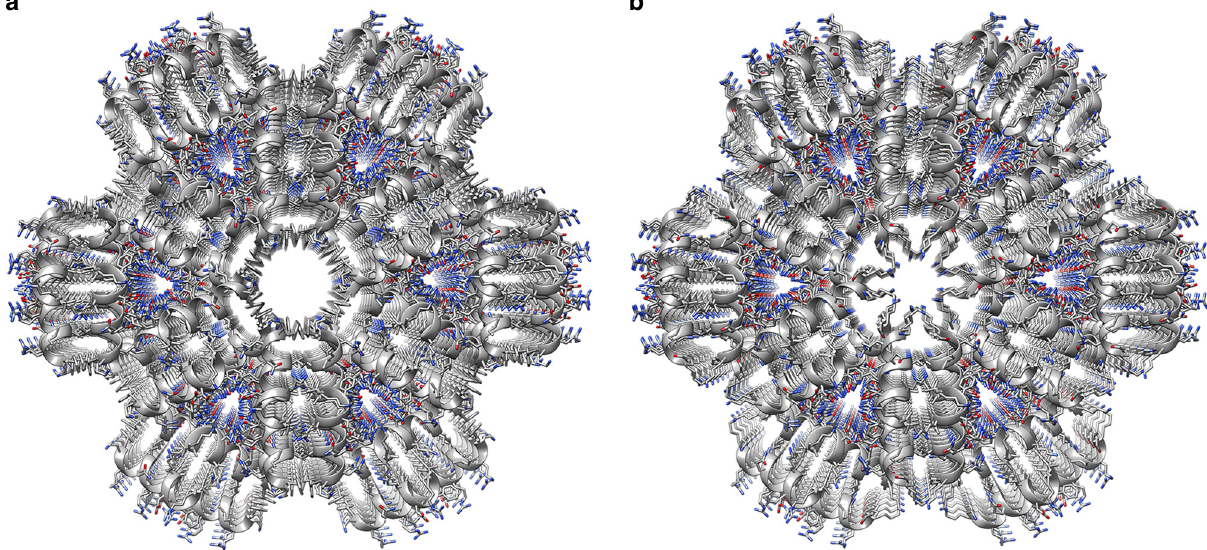
Fig. 7 Human and gorilla LL-37 17-29 share fi brillary architecture but differ in central pore properties. Comparison of human ( a ) and gorilla ( b ) LL-37 17-29 crystal structures, shown in grey ribbons with side chain shown as sticks colored by atom type (oxygen in red and nitrogen in blue). The view is down the fi bril axis, showing the hexametric arrangement and the central pore. The overall structure of the two is highly similar (RMSD of 0.15 Å for the asymmetric unit, comprising two helices and a similar space group and unit cell dimensions (Table 1)). The N-termini of the helices, with Phe17 in hLL-37 17-29 or Ser17 in gLL-37 17-29 , and Lys18, line the central pore. The pore of gLL-37 17-29 is more occluded, due to the orientation of the lysine residues extending into the pore. In the hLL-37 17-29 structure, the lysine residues are almost perpendicular to the cross-section of the curves. MIC values were de fi ned as the minimal concentration of the peptide which yielded less than 20% of the AUC of the control (bacteria with no added peptides). All experiments were performed in triplicates and were averaged. The entire experiment was repeated at least three times on different days, and the mean was calculated from the averaged triplicates of all biological repeats. Error bars repre- sent standard errors of the mean. Two-tailed unpaired t-tests were performed to compare the mean MIC values of tested mutant peptides or derivatives to that of LL37 17-29 .